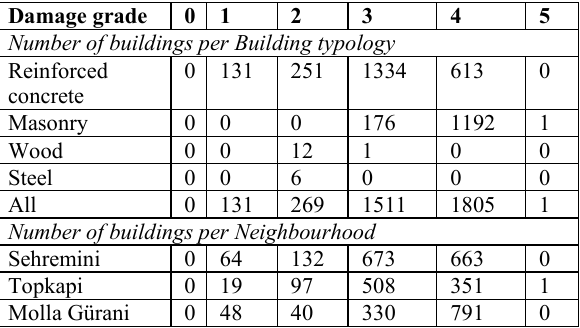
Table 6 . Building damage statistics. Source: de Vries, 2022